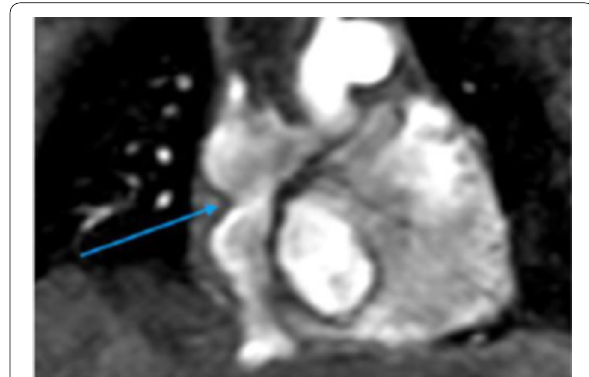
Fig. 22 Still-shot MRI SSFP cine in the coronal view. Stenosis within the intra-atrial tunnel in a patient with a Fontan circuit (blue arrow). Re-used with permission from Fontan circulation in an adult: A guide for the radiologist. Arzanauskaite M, Nyktari E, Voges I. ESTI-ESCR 2018